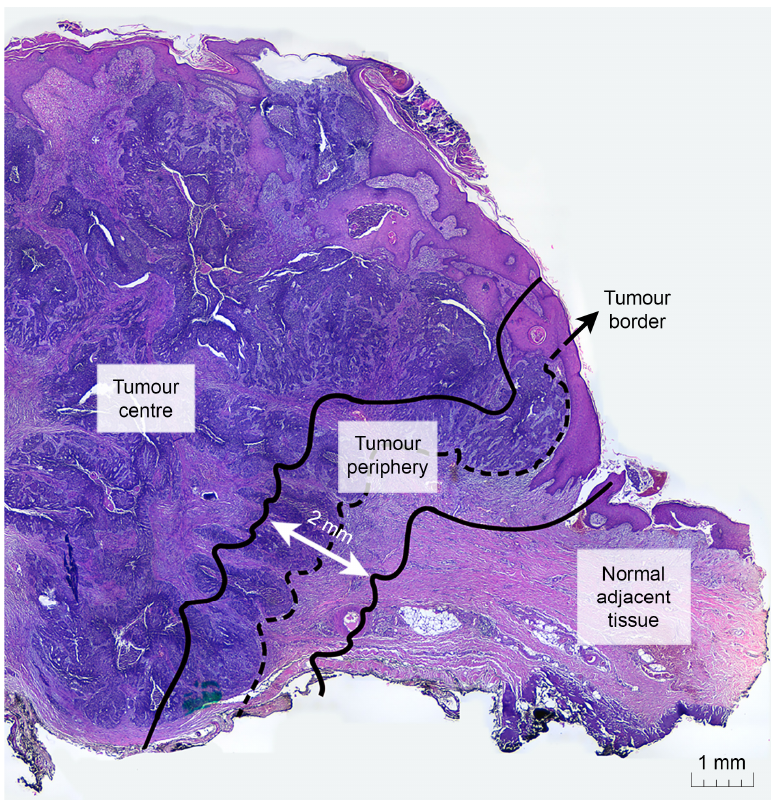
Figure 1. The tumour periphery (TP) is defined as the zone centred on the tumour border separating the normal adjacent tissue (NAT) from the tumour nests, with an extent of 2 mm. The tumour centre (TC) corresponds to all the tissue on the inner side of the TP, while NAT refers to the area on the outer side of the TP.